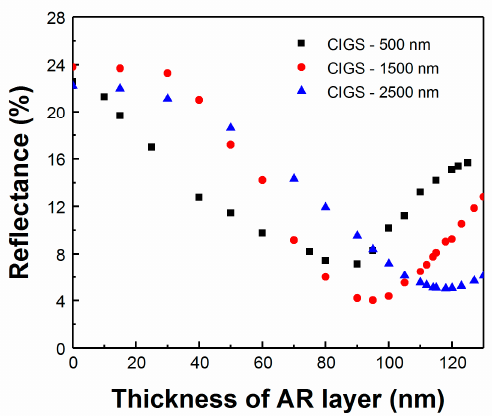
ff erent CIGS layer